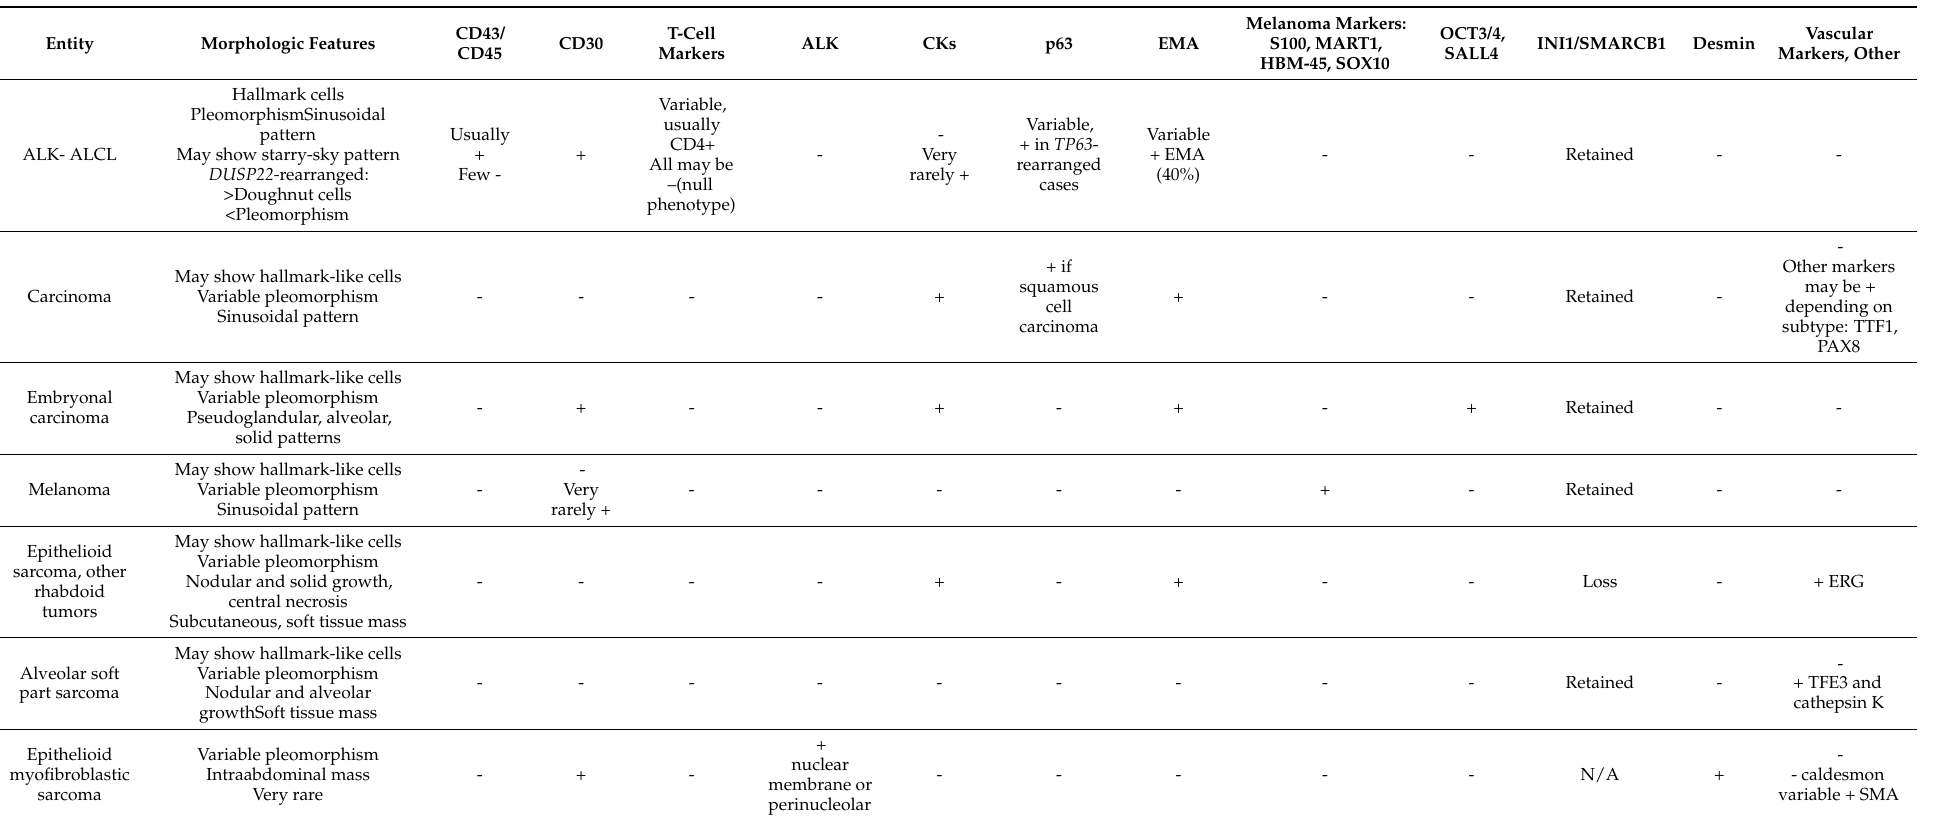
Table 2. Differential diagnosis of ALK- ALCL and non-hematopoietic tumors (lymph node metastasis or extranodal